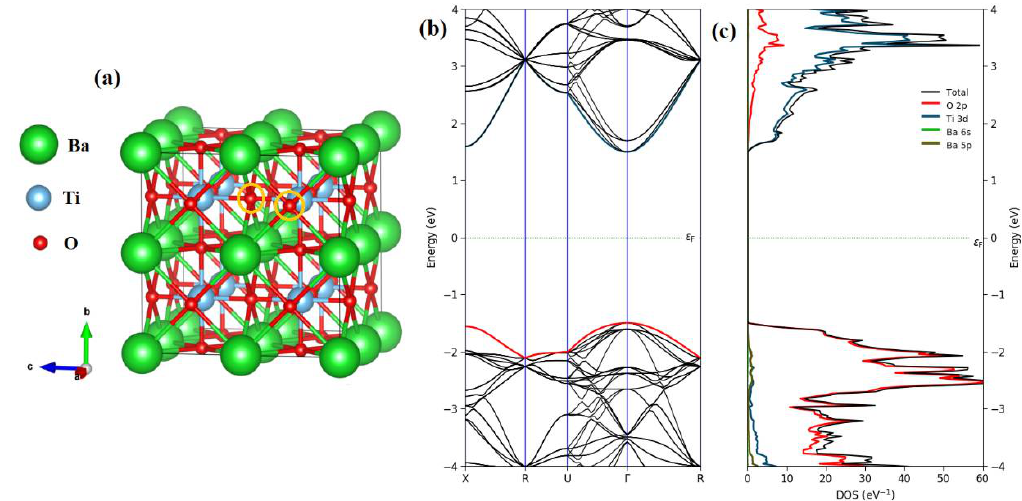
Figure 1. ( a ) The optimized supercell structure of 2 × 2 × 2 supercell and ( b ) calculated band structure and total and partial DOS of pristine BaTiO3. (Ba in green, Ti in light blue, O in red, orange circles of doping atoms).